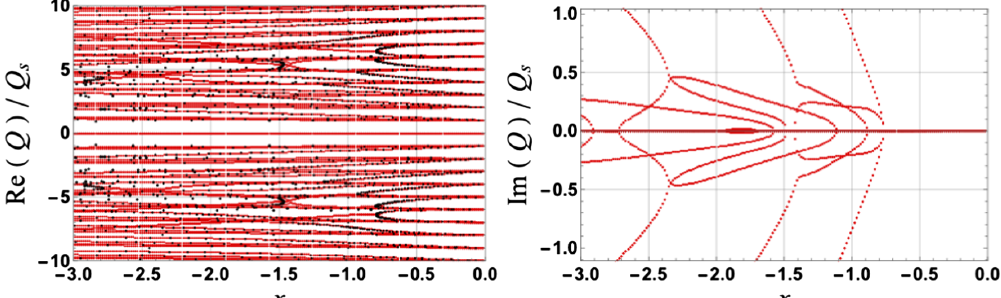
FIG. 3. Comparison between GALACTIC (in red) and Laclare [29] (in black) of the normalized mode-frequency shifts, in the case of a broadband resonator impedance (with a quality factor of 1 and a resonance frequency f distribution [29]: (left) real part and (right) imaginary part (from GALACTIC only).